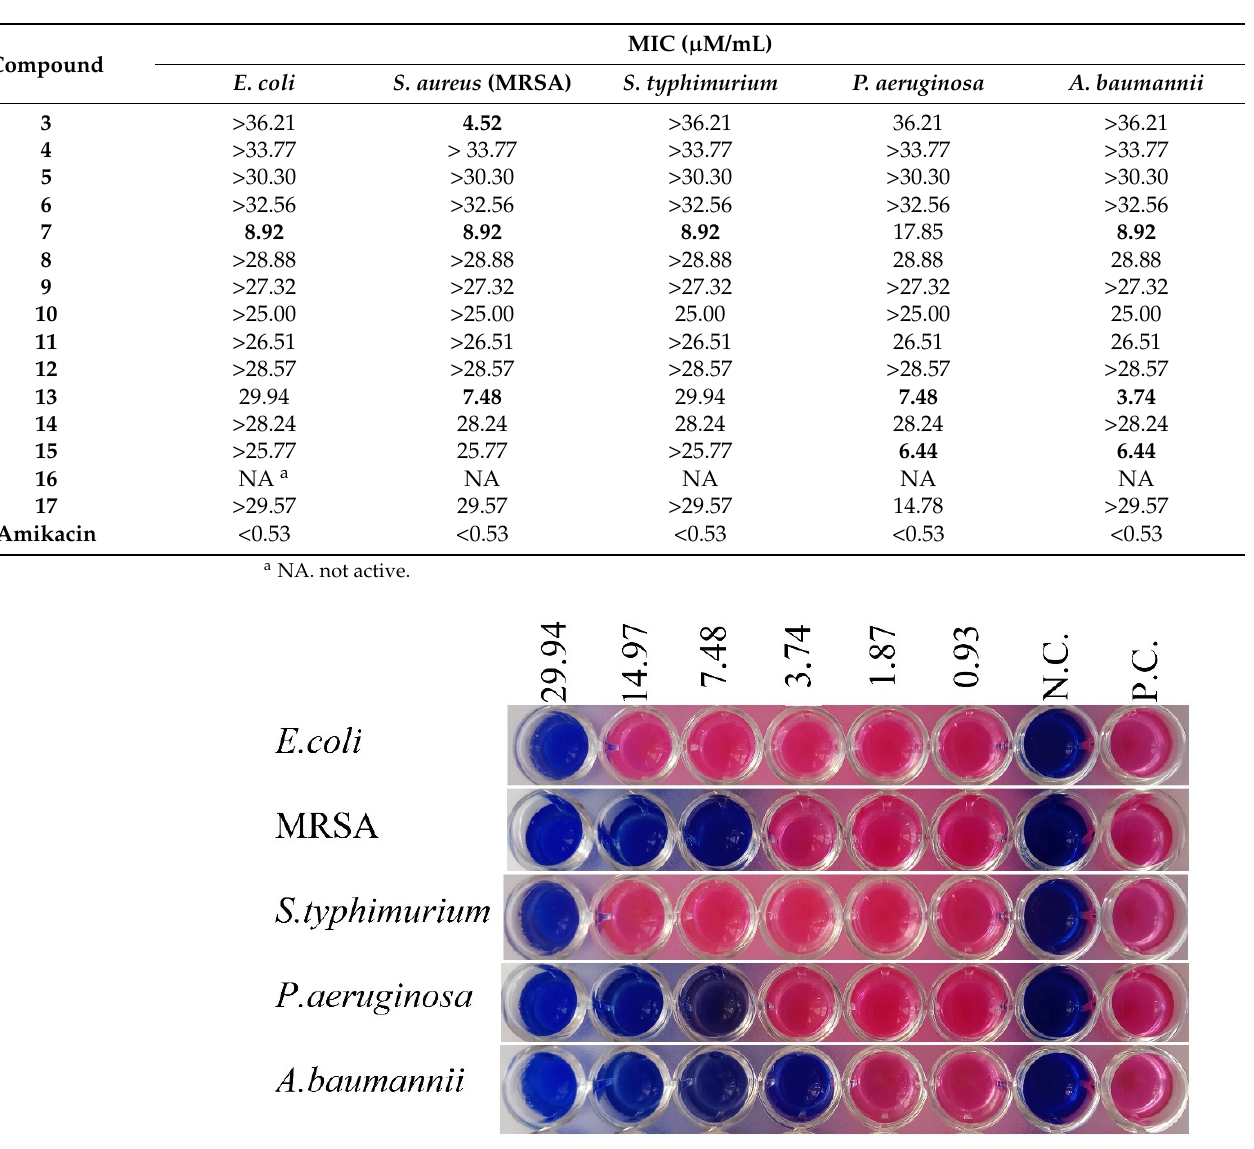
Table 2. Antibacterial activity of the synthesized compounds ( 3 – 17 ).